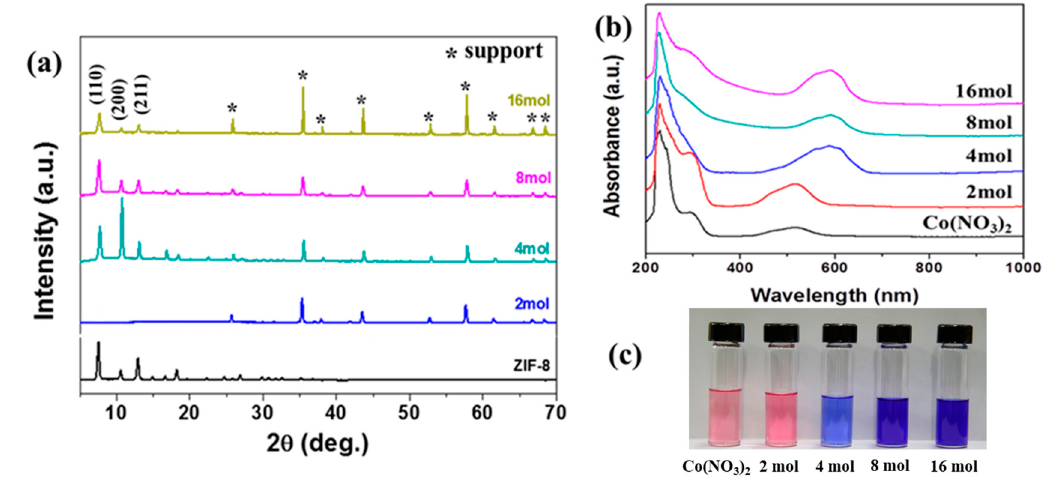
Figure 6. ( a ) XRD patterns for Co44-ZIF-8 membrane with different mIM concentrations: 2, 4, 8, and 16 mmol at 100 °C for 2 h, ( b ) UV–Vis spectra, and ( c ) color changes of synthetic